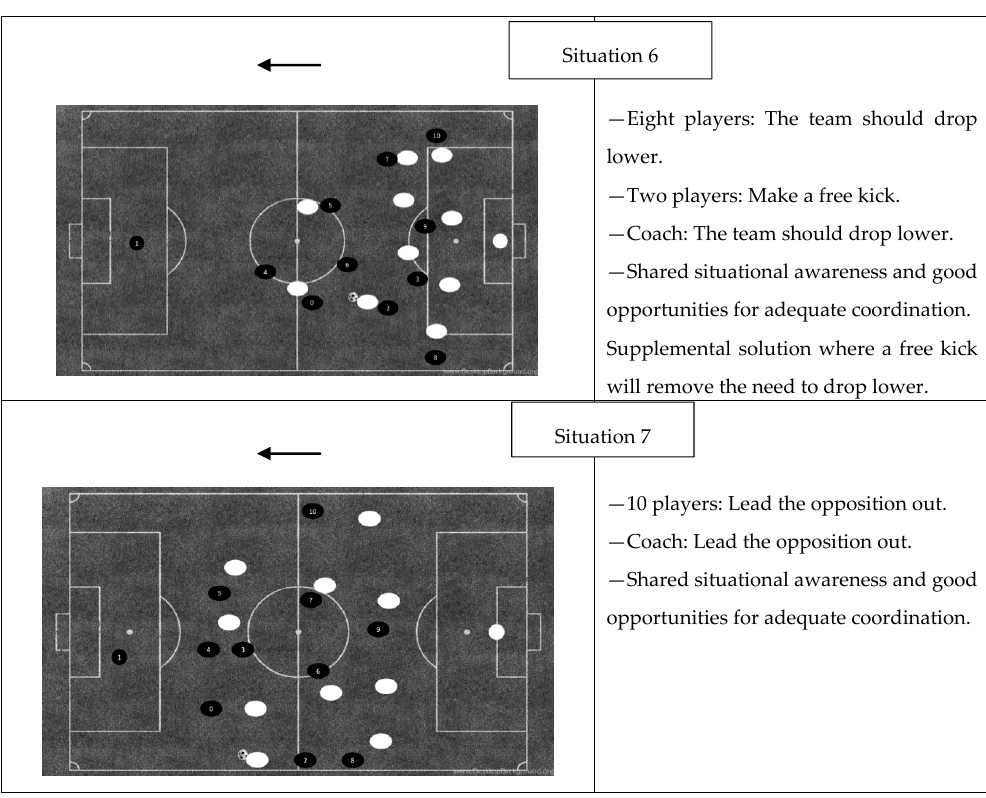
Figure 1. Defensive situations and the distribution of player responses in categories. Players with numbers represent the inquired team and the arrow specifies the attacking direction. Player 0 is the player that did not participate in the study.